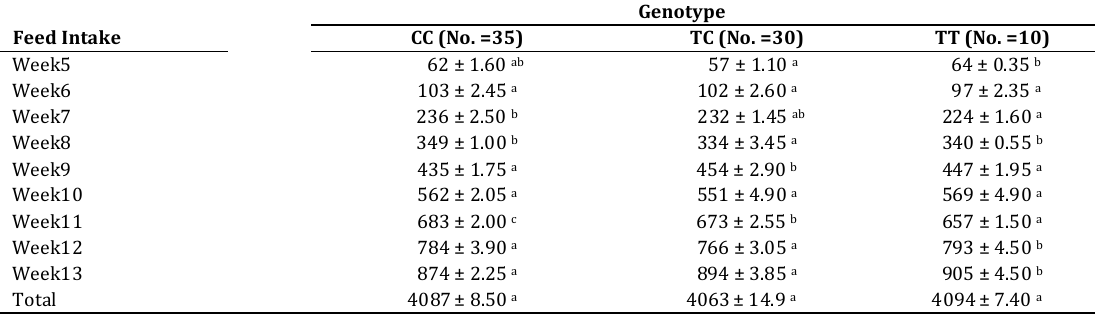
Table 5. Relationship of genotypes of the TGF- β2 gene with feed intake (g). Mean ± standard error